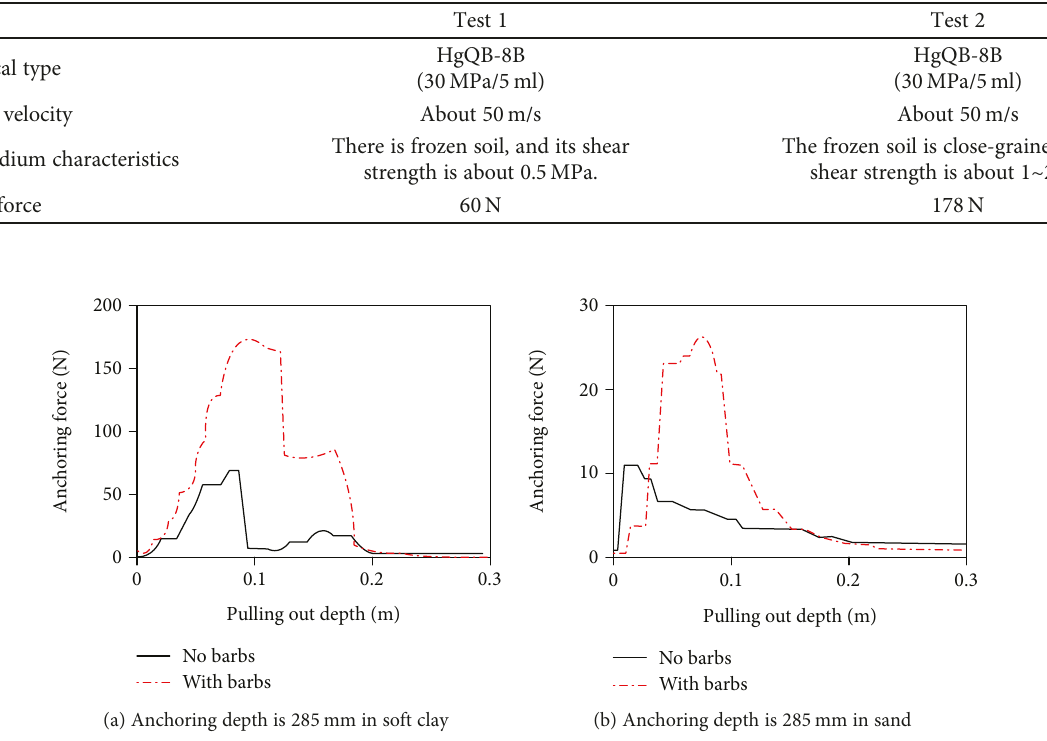
Figure 21: Anchoring force of anchor body with and without